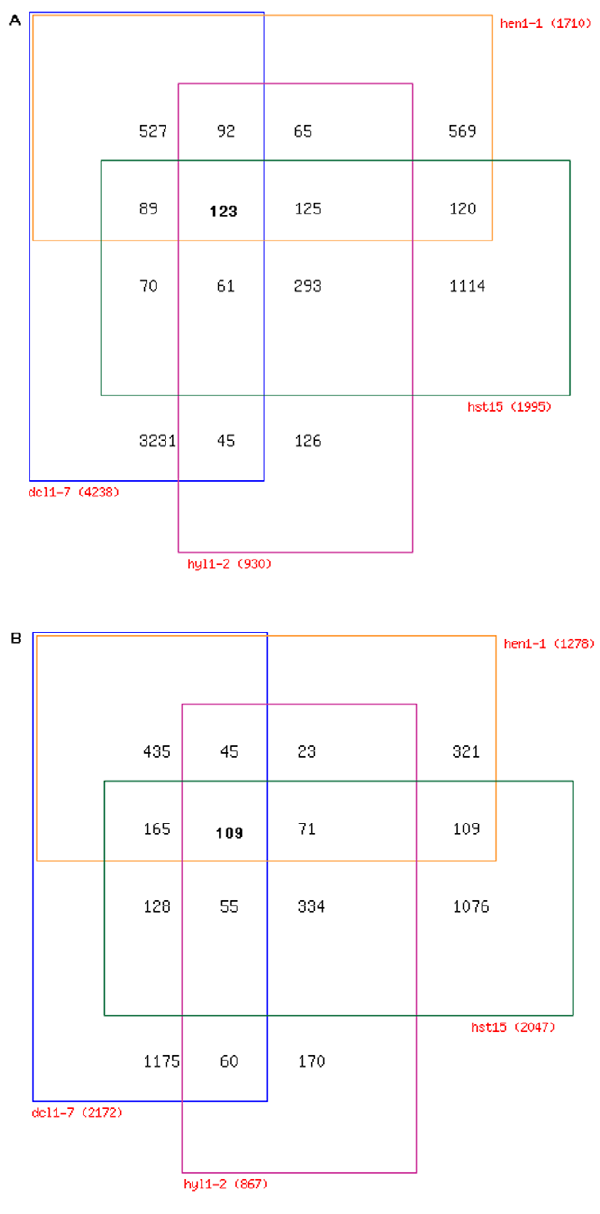
Figure 2. Venn diagrams showing up- and down-regulated genes across the mutants dcl1-7 , hen1-1 , hyl1-2 and hst15 . (A) Among up-regulated genes, 123 genes were shared among the miRNA mutants. 117 of the 123 genes have no cross-hybridization and were chosen for further study. (B) Among down-regulated genes, 109 genes are shared among the miRNA mutants. 105 of the 109 genes have no cross-hybridization and were chosen for further study.